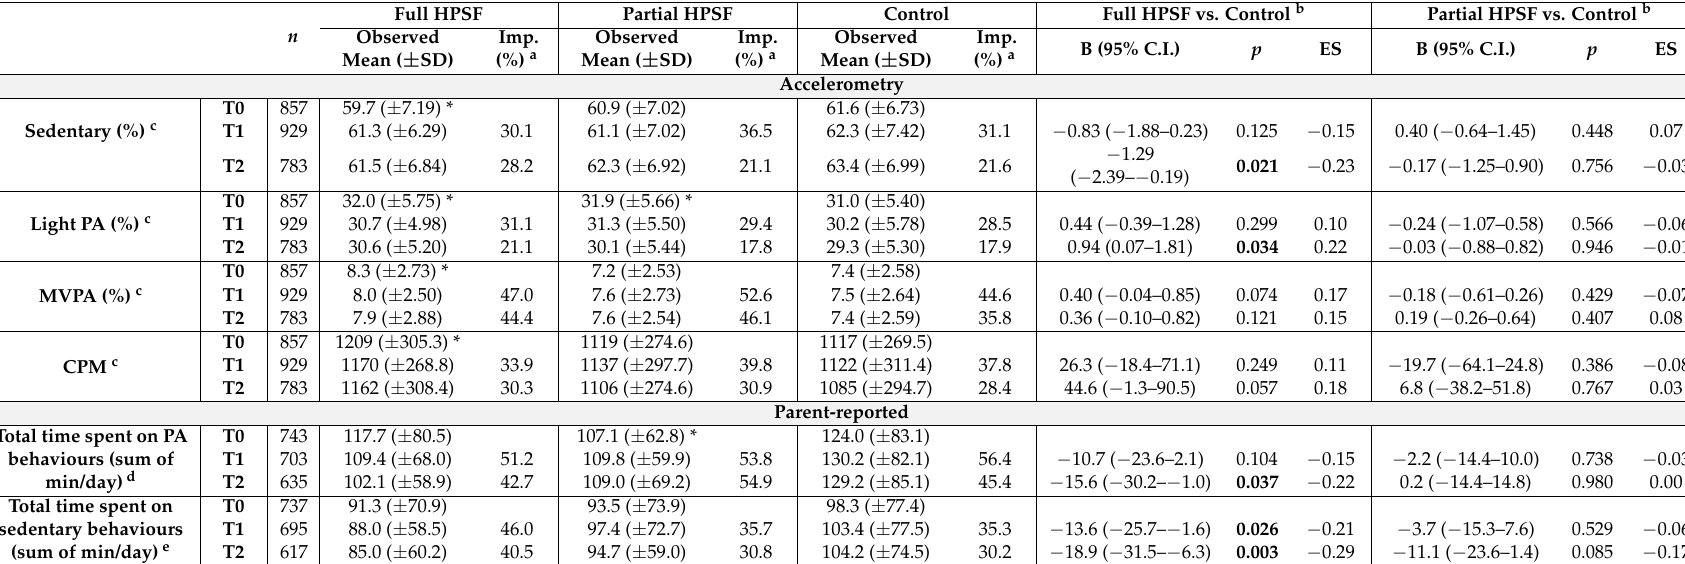
Table 1. Children’s PA behaviours: Observed descriptives and estimated 1- and 2-year